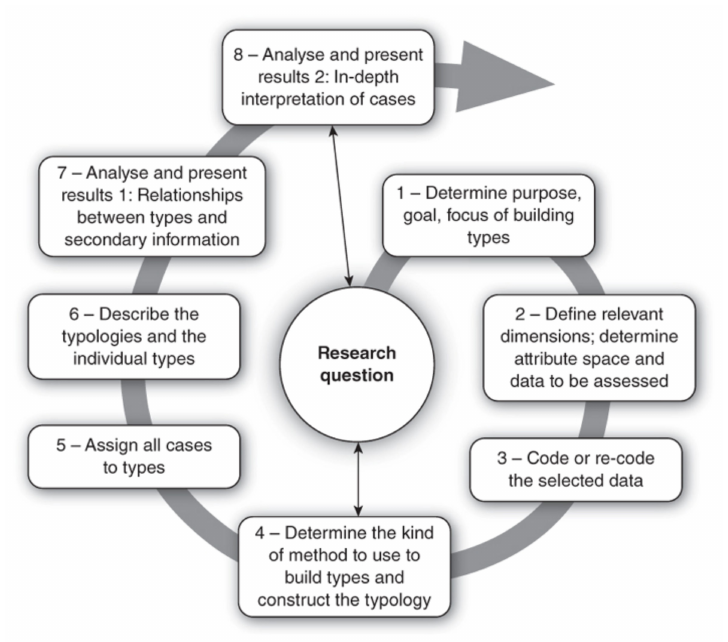
Figure 2. Qualitative research process